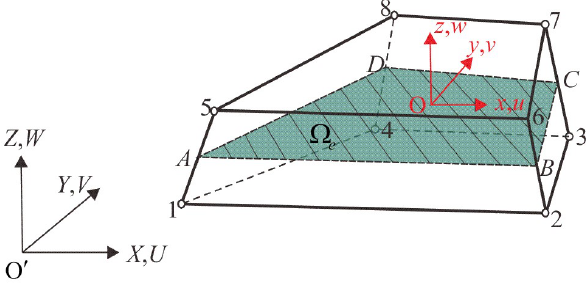
Figure 1: The geometry and coordinates of the solid-shell element